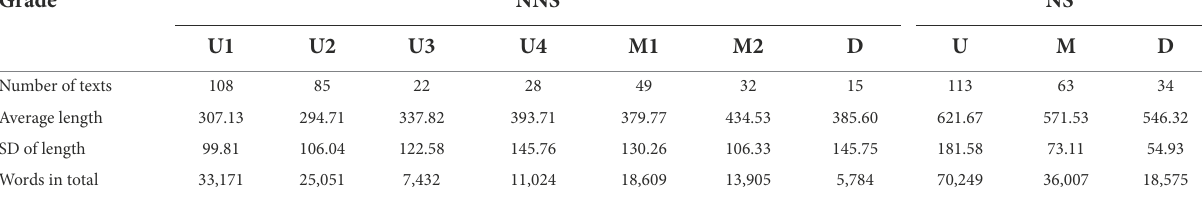
TABLE 1 Sample distribution in NICE.